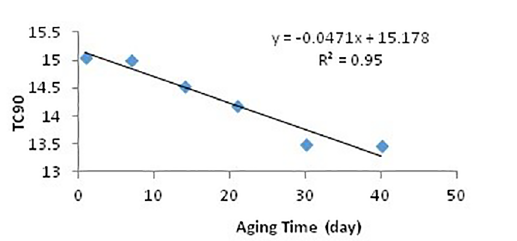
Figure 5. CRI vs. Aging time